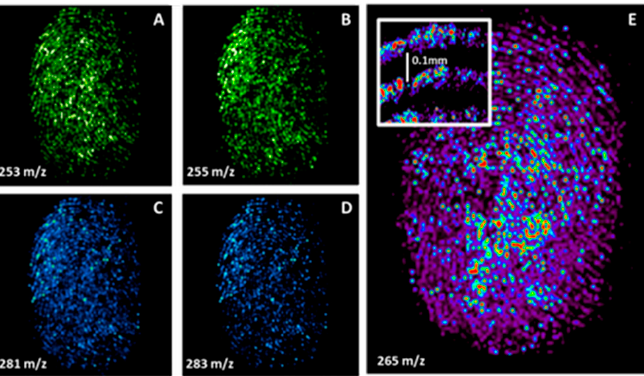
Figure 3. Endogenous compounds in LFMs. ( A – D ) Palmitoleic, palmitic, oleic, and stearic acids, respectively. ( E ) The distribution in negative ion mode of SDS.